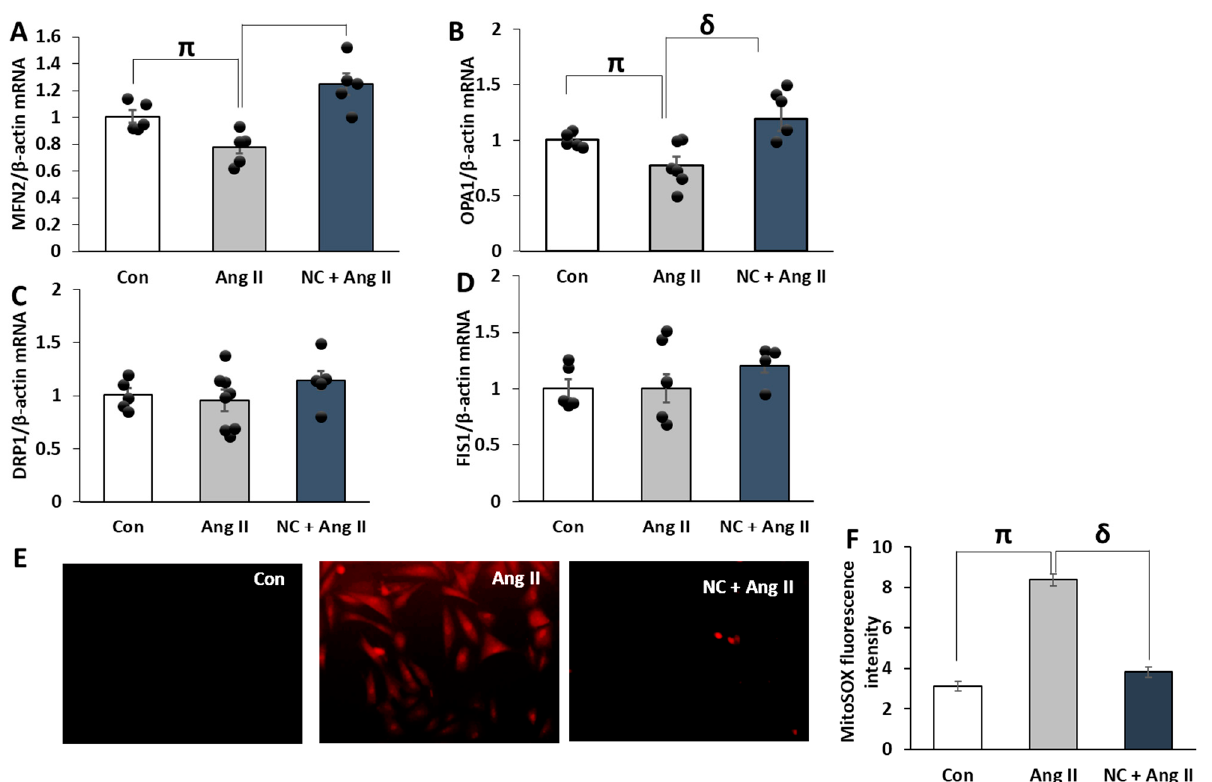
Figure 8. NC changed the mRNA expression of genes regulating mitochondrial dynamics in H9c2 cells. Treatment with NC (10 µg/mL) prior to Ang II (1 µM) upregulated the expression of fusion genes. NC upregulated the mRNA levels of MFN2 ( A ), and OPA1 ( B ) compared to Ang II alone, whereas changes in DRP1 ( C ) and FIS1 ( D ) were not signi fi cant. Panel ( E , F ) images show mitochon- dria ROS generation using Mito SOX red stain and relative fl uorescent intensity of Mito SOX red (n = 6–8 wells for each treatment). π p < 0.05 vs. Con and δ p < 0.05 vs. Ang II. Values are means ± SEM (n ≥ 4–6 independent experiments for each treatment group). 4. Discussion.